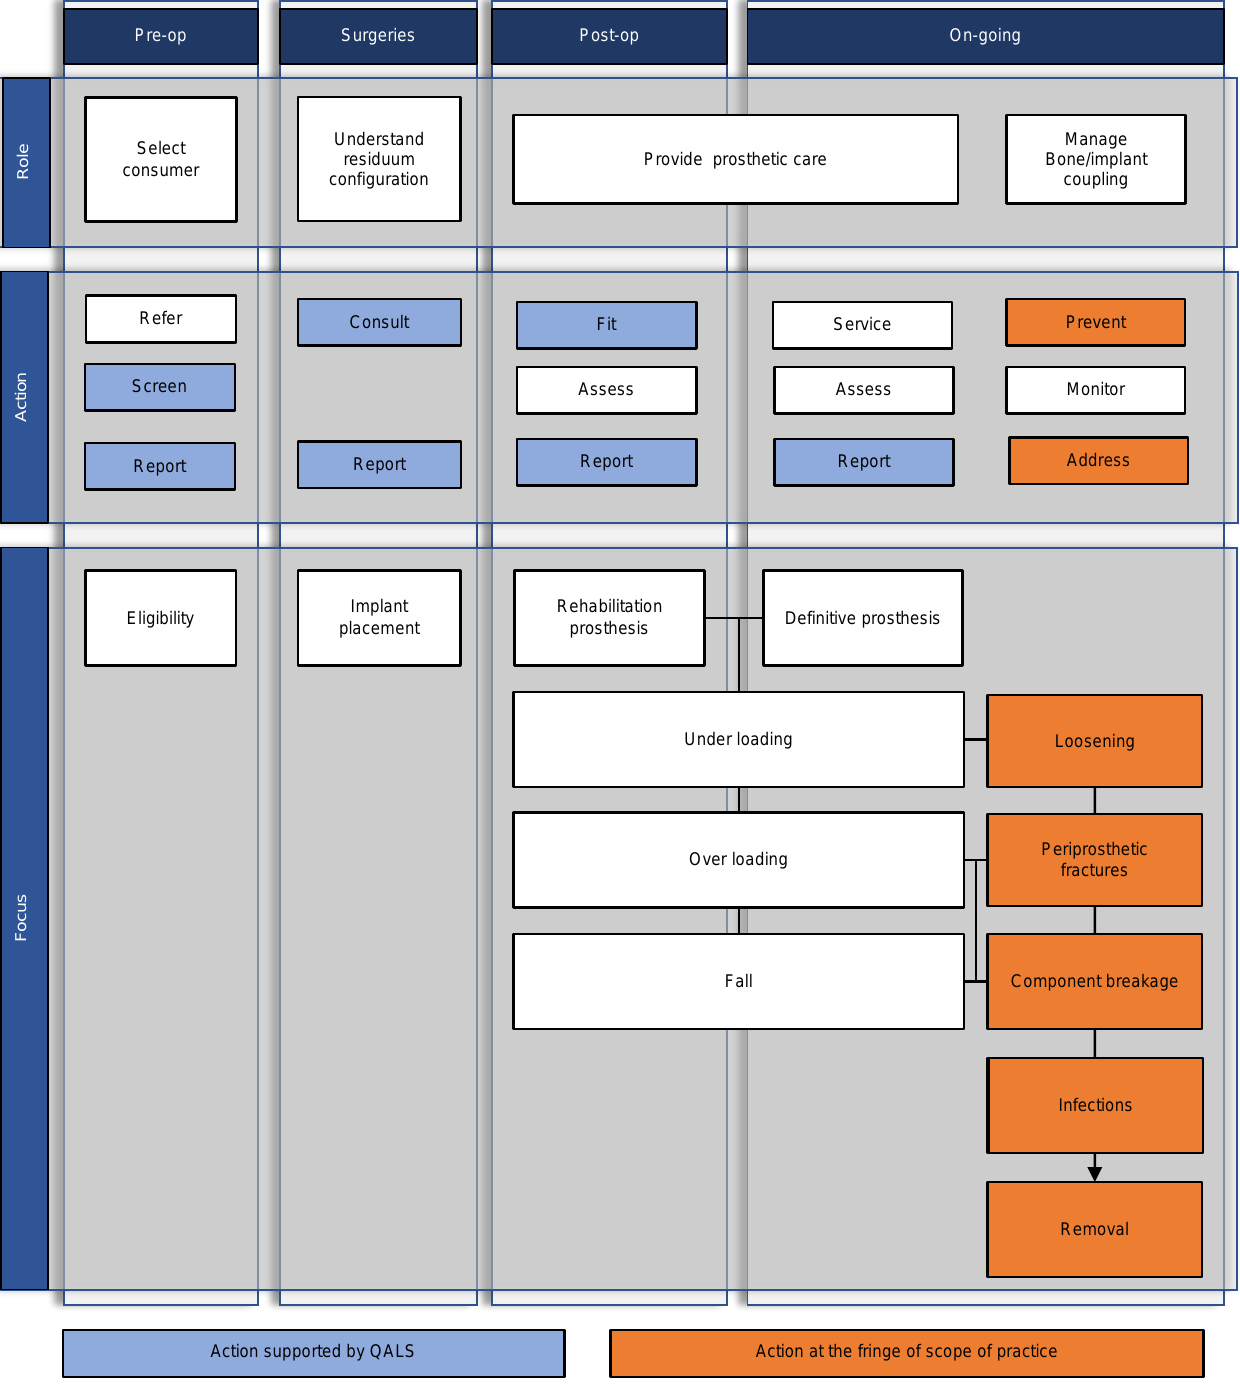
Berg D, Frossard L. Health service delivery and economic evaluation of limb lower bone-anchored prostheses: A summary of the Queensland artificial limb service’s experience. Canadian Prosthetics & Orthotics Journal. 2021; Volume 4, Issue 2, No.12. https://doi.org/10.33137/cpoj.v4i2.36210